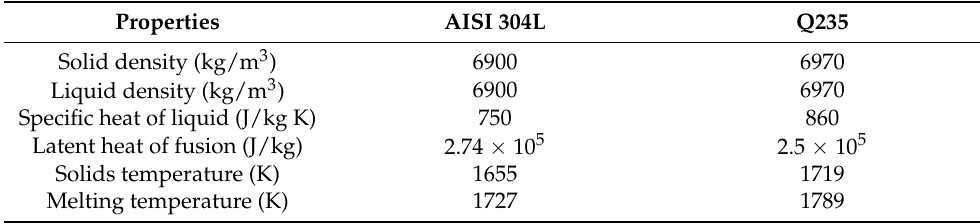
Table 3. The thermal properties of AISI 304L and Q235 steels.